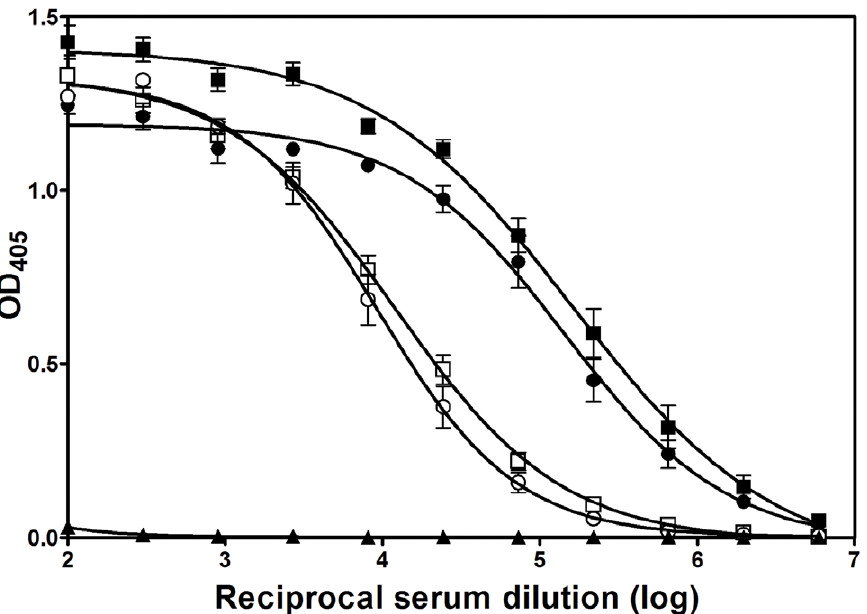
Figure 1. Enzyme immunoassay of Poly s 5- or Pol a 5-specific mouse sera on solid-phase Poly s 5 and Pol a 5. Squares correspond to N Poly s 5-specific sera, which were assayed on Poly s 5 ( & ) or Pol a 5 ( % ) as the solid-phase antigen. Pol a 5-specific sera are designated by circles and ) or Poly s 5 ( # ) as solid-phase antigen. Closed triangles correspond to the preimmune sera. Mean values 6 S.E.M. are were assayed on Pol a 5 ( shown.